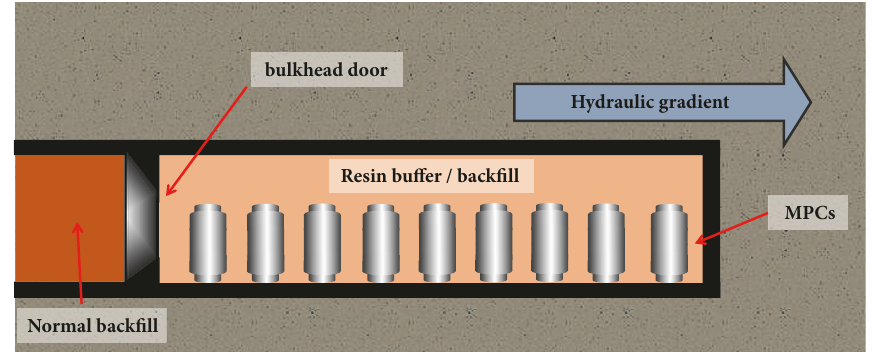
Figure 2: CARE variant infilled with